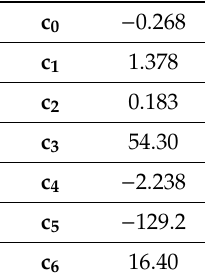
Table 3. Split window coe ffi cient values.